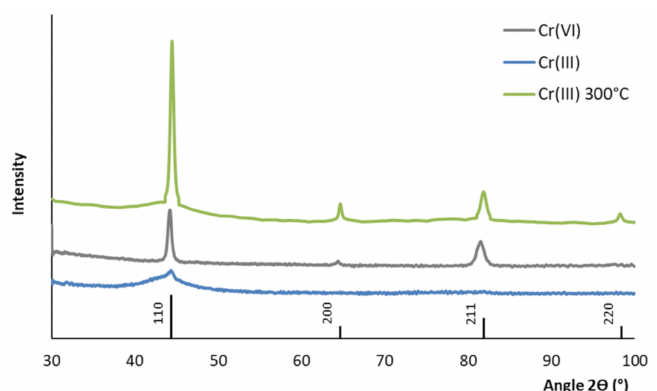
Figure 8. Diffractograms of trivalent chromium and hexavalent chromium